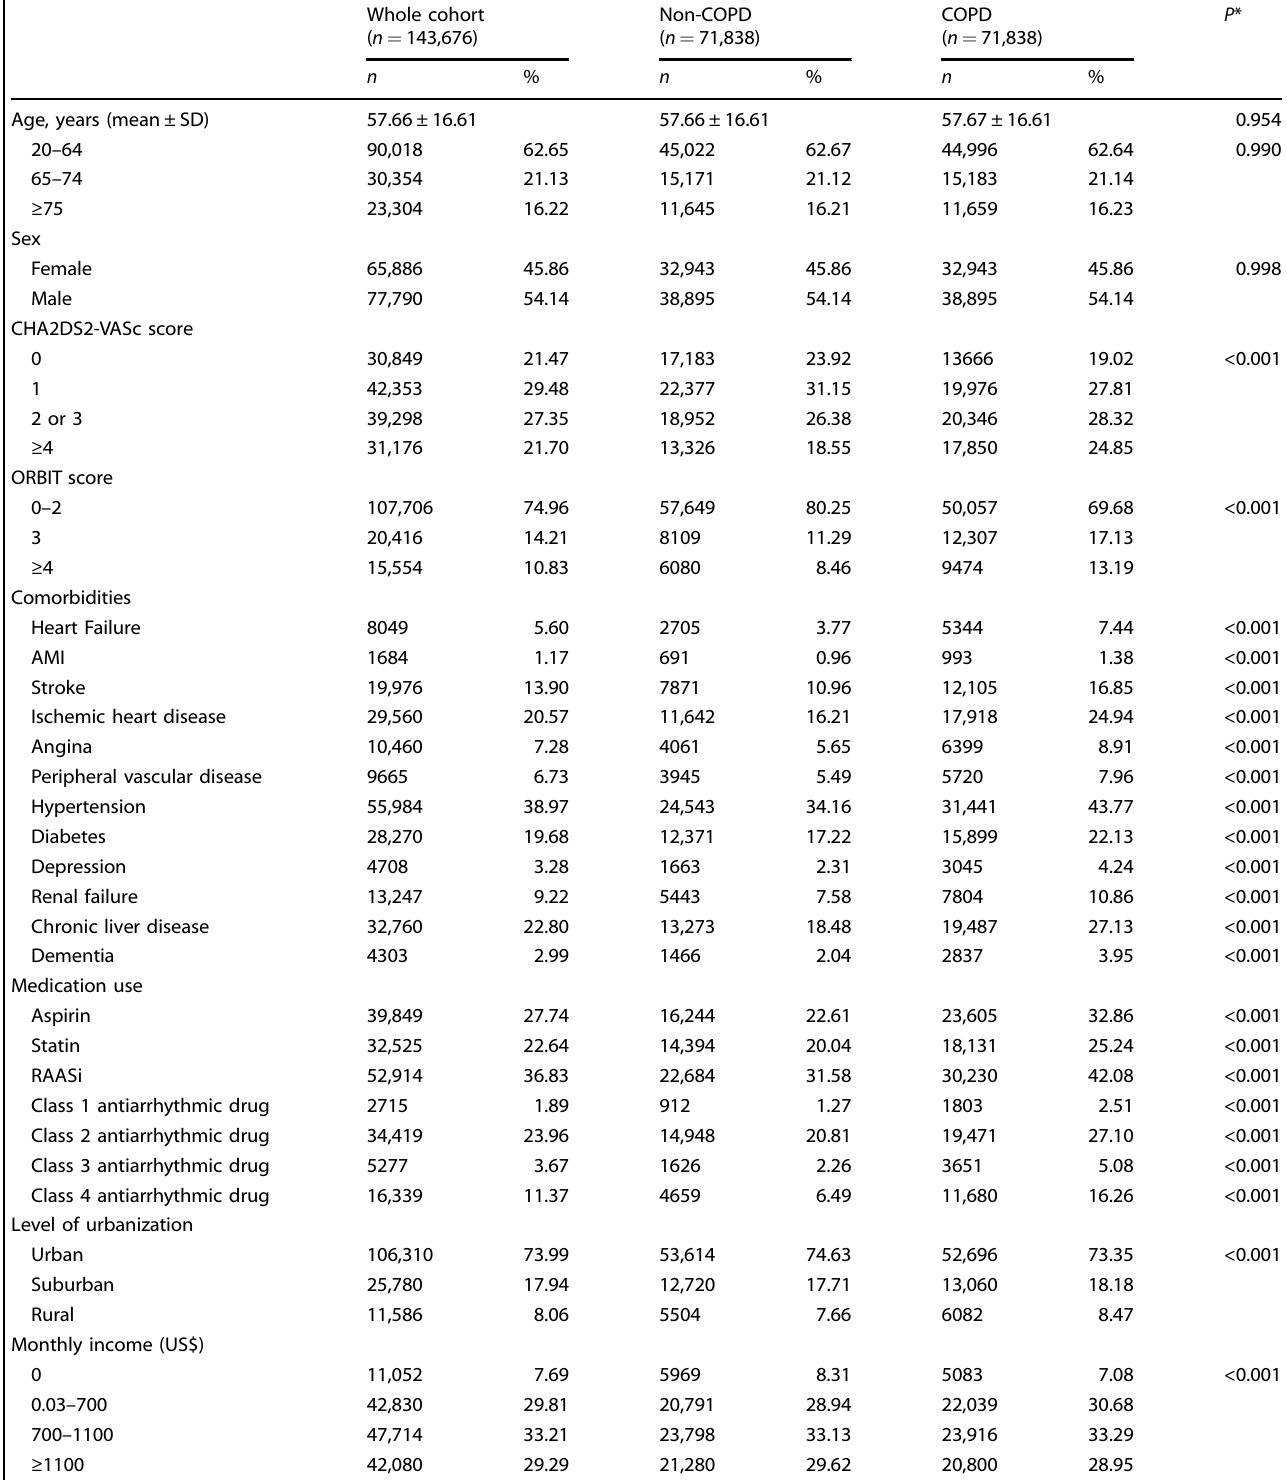
Table 1. Characteristic of the sample population.